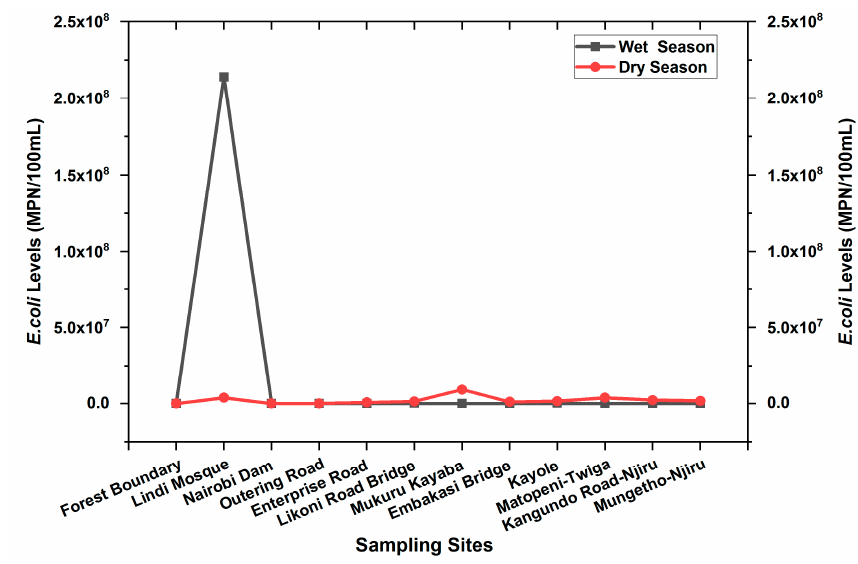
Figure 5. E. coli levels in Ngong River measured between April and August 2021.